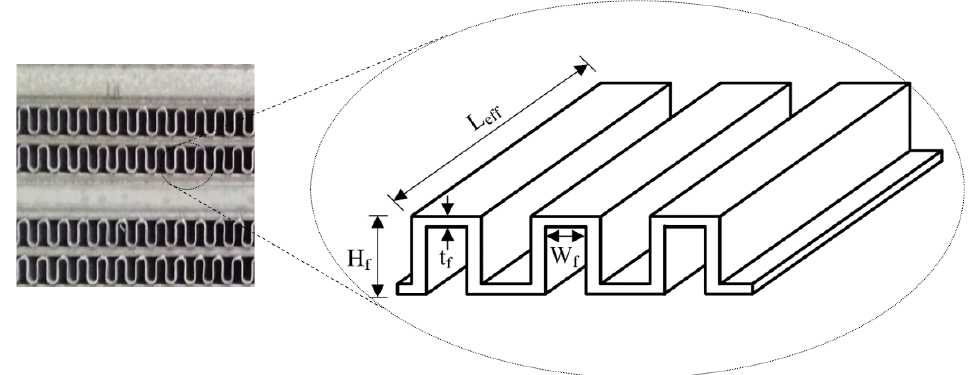
Figure 1. Feature of Plate–Fin Heat Exchanger (PFHE).